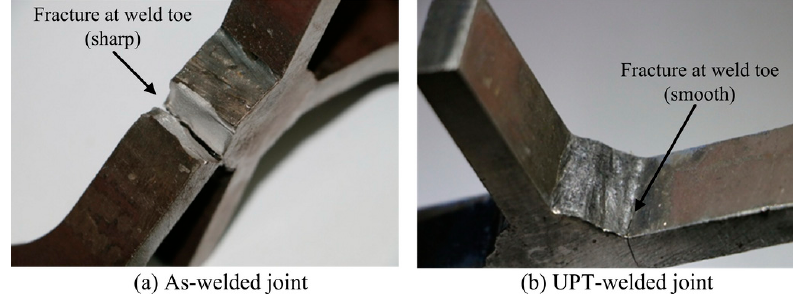
Figure 8. The fracture positions of ( a ) an as-welded joint; and ( b ) UPT-welded joint.